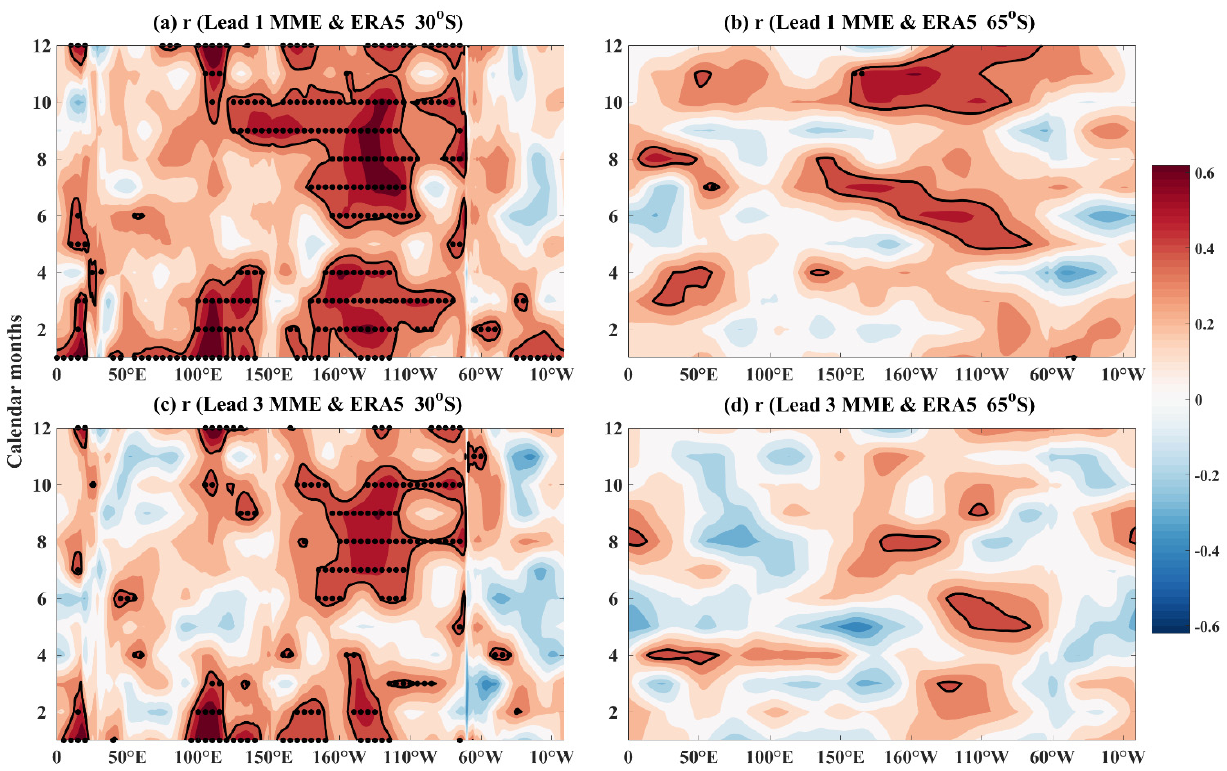
Figure 10. Similar to Figure 9, but for the evaluation of the sea-level pressure at 30° S and 65°